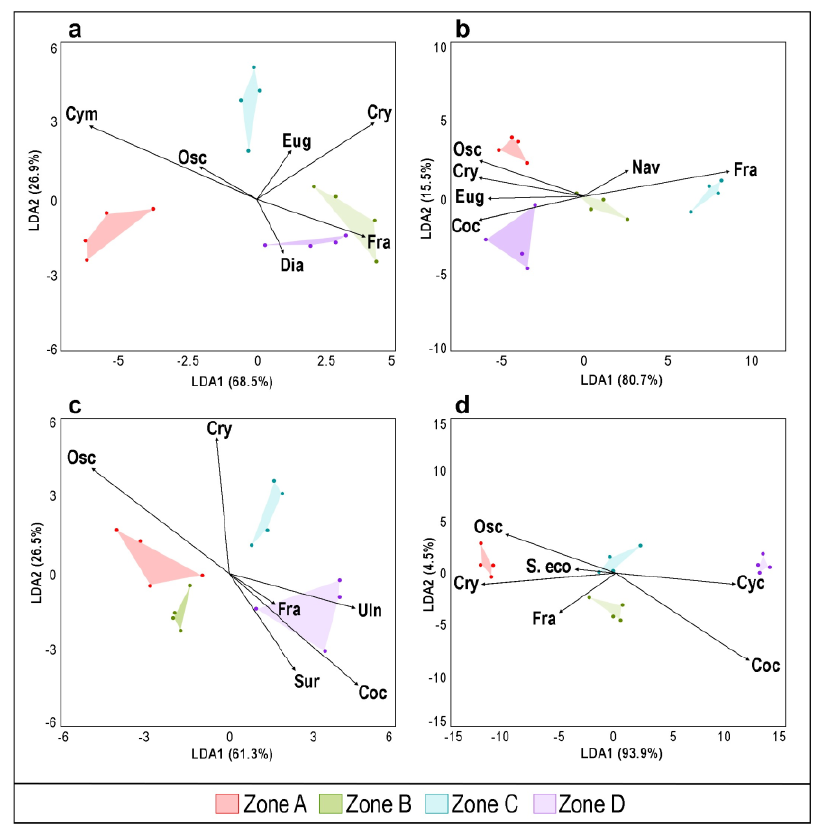
Figure 5. Graphs representing linear discriminant analysis (LDA) based on the phytoplankton taxa. ( a ): April; Graphs ( b ): July; Graphs ( c ): October; Graphs ( d ): December. Whereas Coc: Cocconeis pe- diculus ; Uln: Ulnaria ulna ; Dia: Diatoma vulgaris. ; Cry: Cryptomonas ovata ; Osc: Oscilatoria sp . ; Cym: